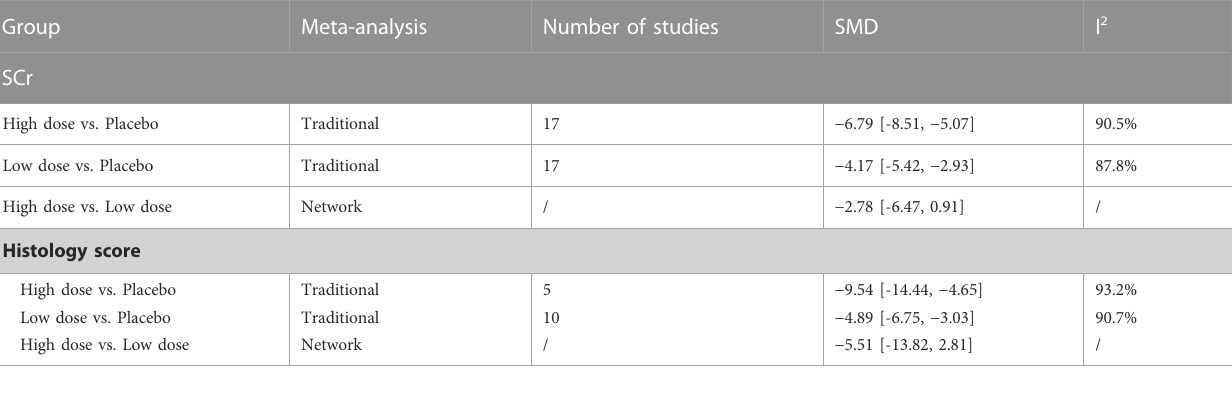
TABLE 4 Comparison of different doses in vein transplantation group.